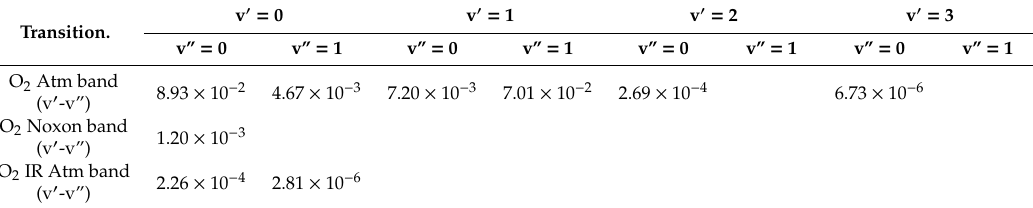
Table 3. Measured values of Einstein coe ffi cient (s − 1 ) for O 2 bands systems [72,73]. Transition.